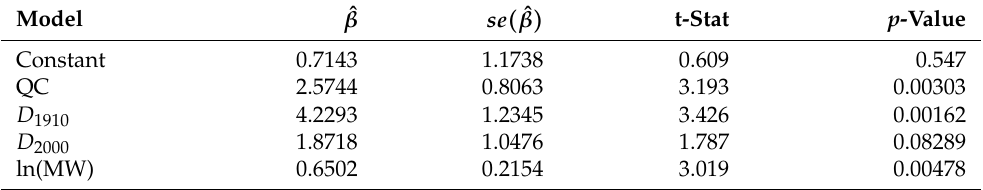
Table 5. Dependent variable: Time—coefficients for hydroelectric power plant model.